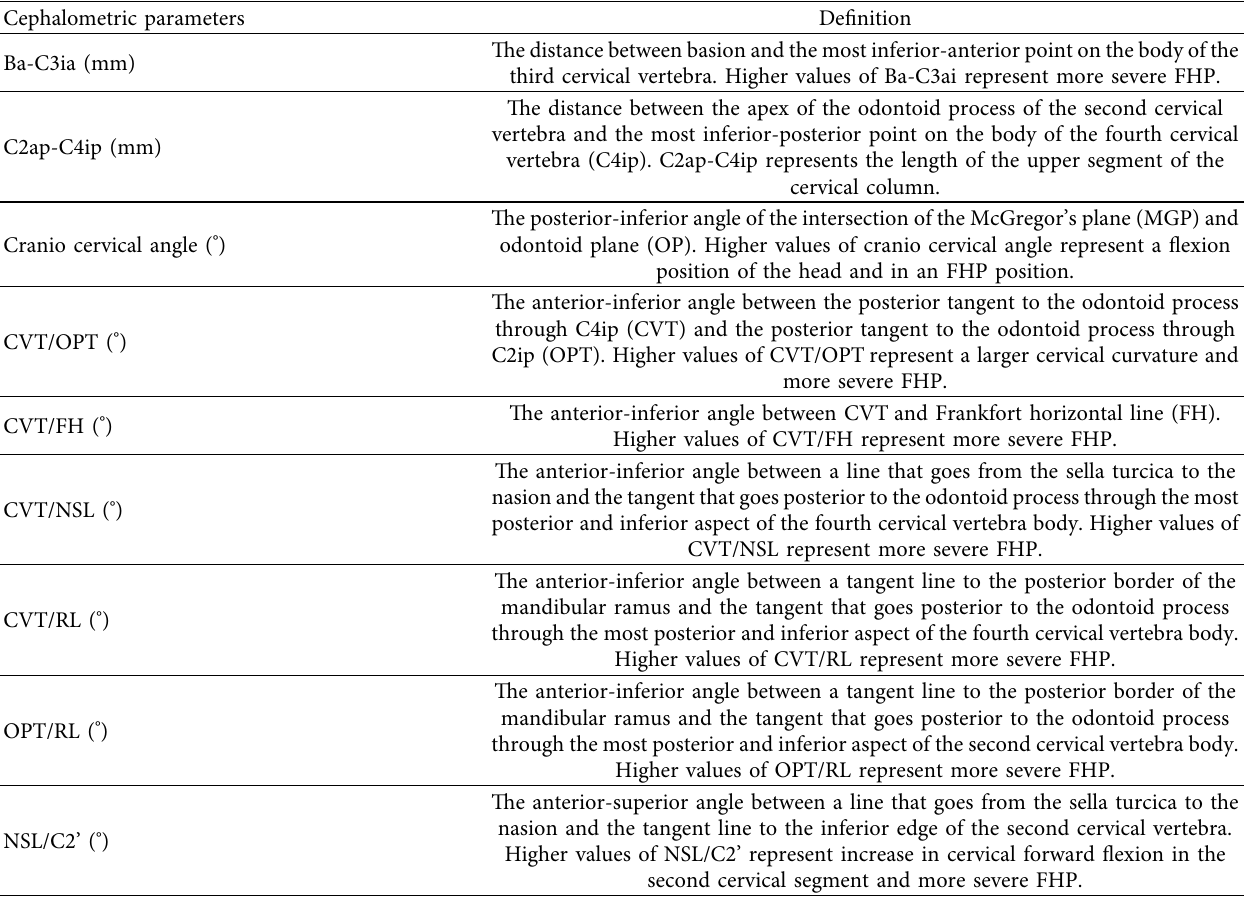
Table 1: Cephalometric parameters used in this